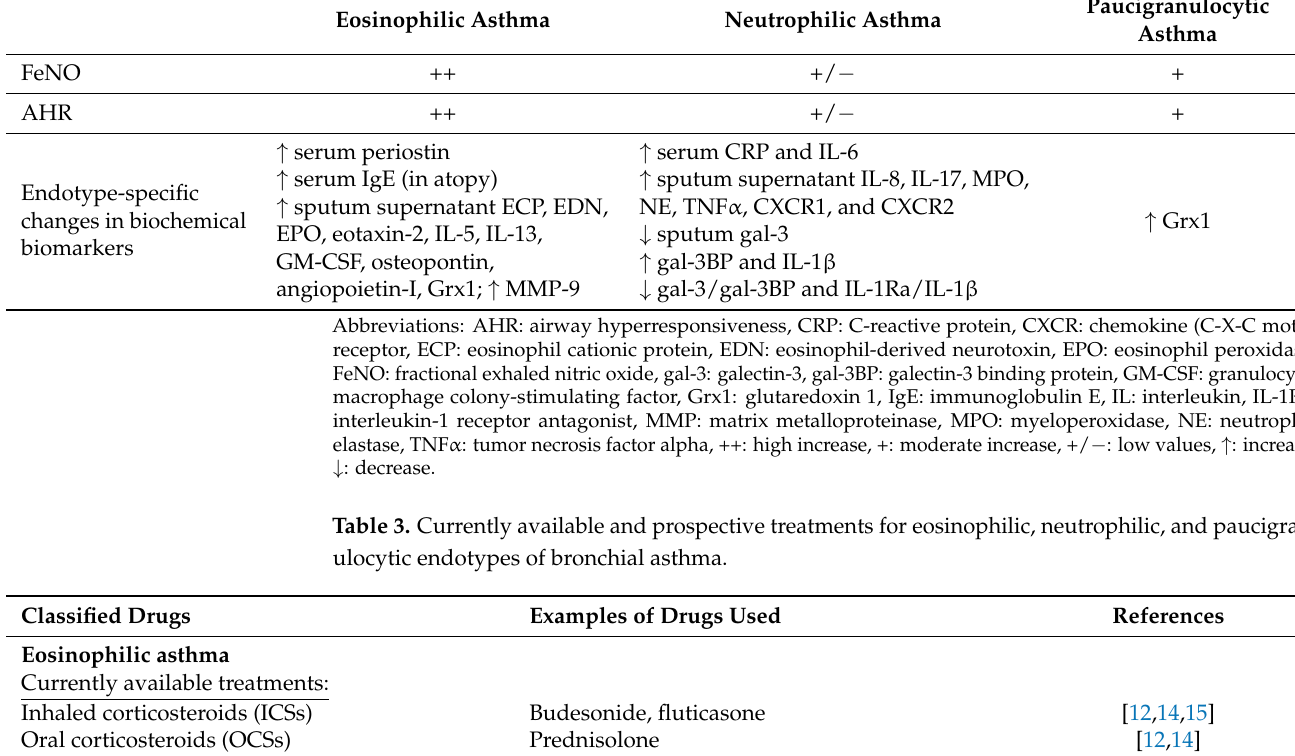
Table 2. Potential clinical and biochemical biomarkers for the eosinophilic, neutrophilic, and pauci- granulocytic endotypes of bronchial asthma (modified from [1–3,8]). Eosinophilic Asthma Neutrophilic Asthma